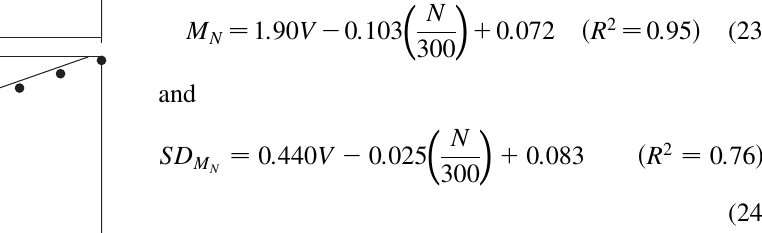
versus overlap V , N